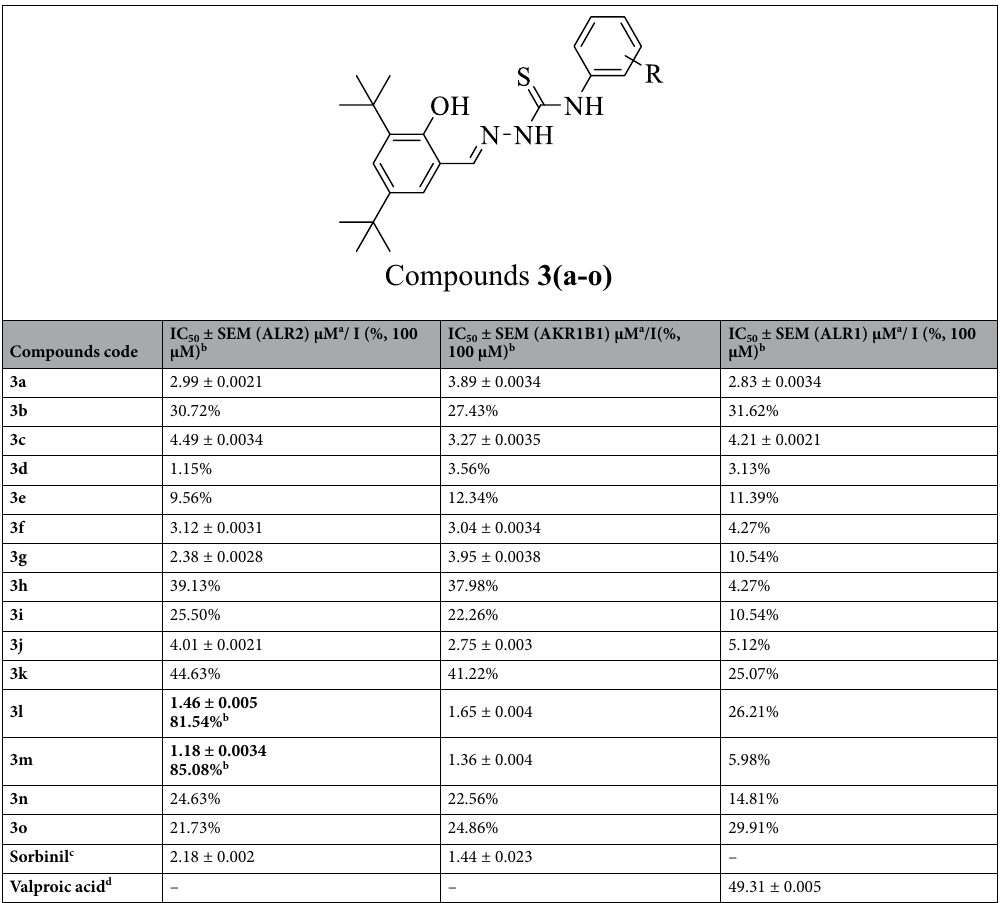
Table 1. IC 50 values for ALR1 and ALR2 inhibition. a The IC 50 value (the half-maximal inhibitory concentration) is the concentration of drug required to decrease enzyme activity by 50%. b The percentage inhibition for enzymes measured at 100 µM of inhibitor concentration. c Sorbinil is a standard inhibitor of ALR2. d Valproic acid is a standard inhibitor of ALR1. Results are mean values ±SEM based on three measurements. Synthesized compounds’ codes were written in bold text whereas the most significant and selective inhibitor’s values were made bold upon suggestion of reviewer’s